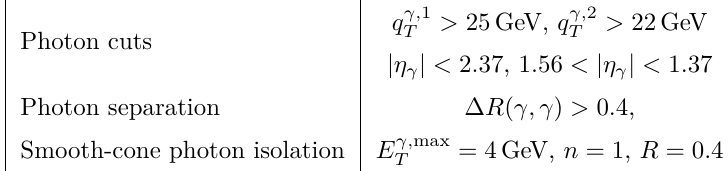
√ s = 7 TeV , see ref.